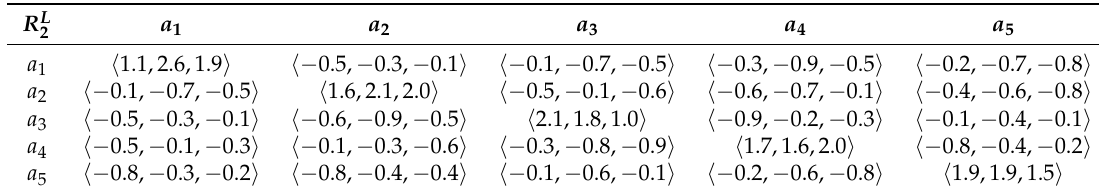
Table 6. Elements of the Laplacian matrix of the SVNDG